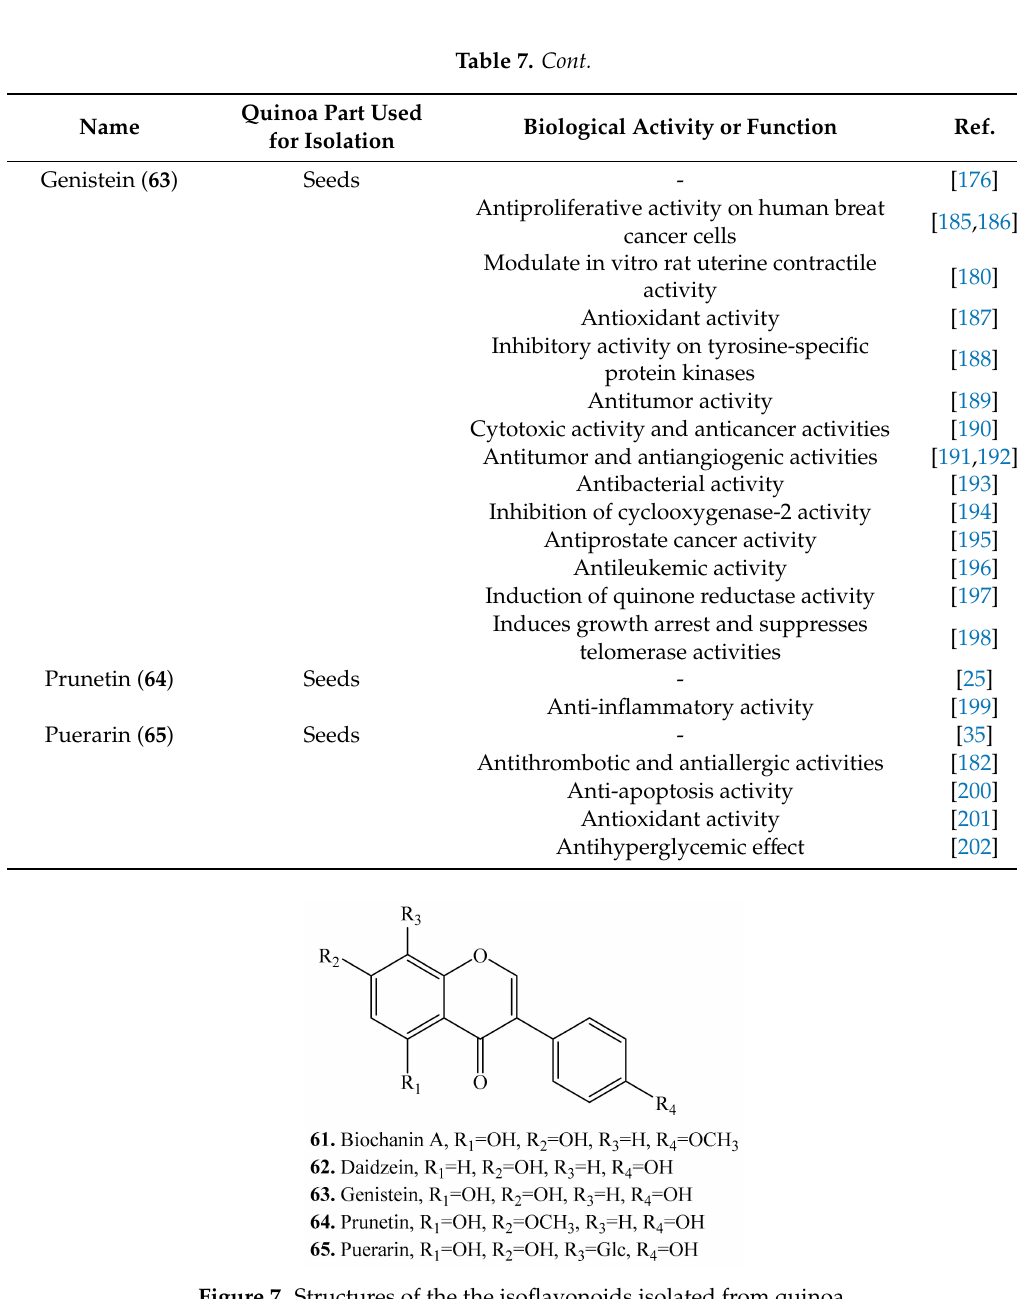
Figure 7. Structures of the the isoflavonoids isolated from